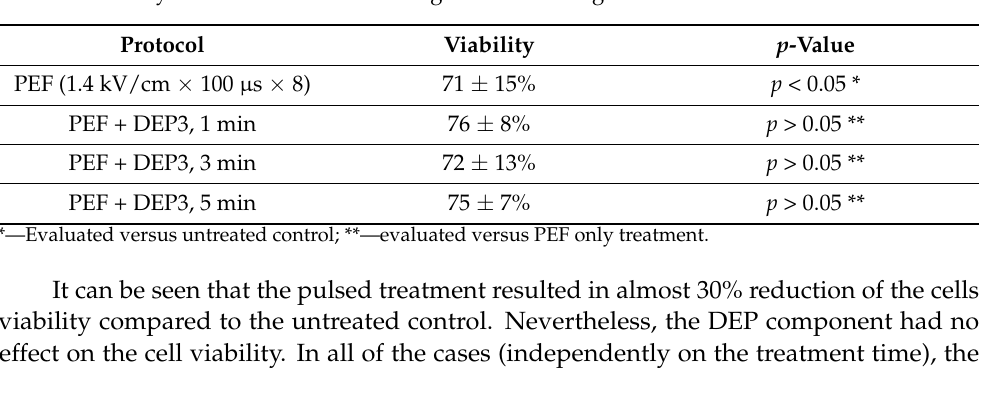
Figure 5. The effects of electroporation and dielectrophoresis on electrotransfection efficiency, where ( A ) dependence of the number of GFP positive cells on various combinations of both treatments; asterisk (*) corresponds to statistically significant ( p < 0.05) difference versus PEF only treatment; and ( B ) effects of exposure time during the DEP application step, where statistical significance was evaluated between different DEP-assisted treatments (DEP1–DEP3).